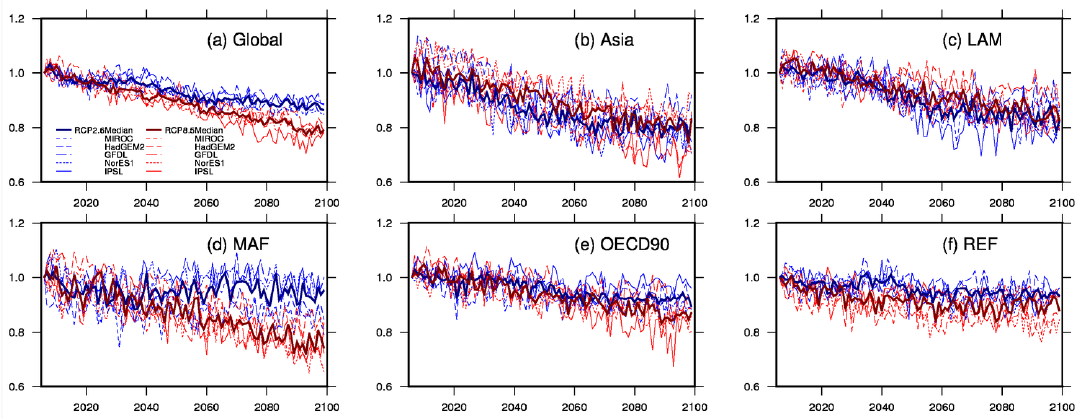
Figure 6. Sufficiency in thermal power cooling water ( a ) globally, and in ( b ) Asia, ( c ) Latin America (LAM), ( d ) the Middle East and Africa, ( e ) OECD, and ( f ) countries with transitional economies (REF).